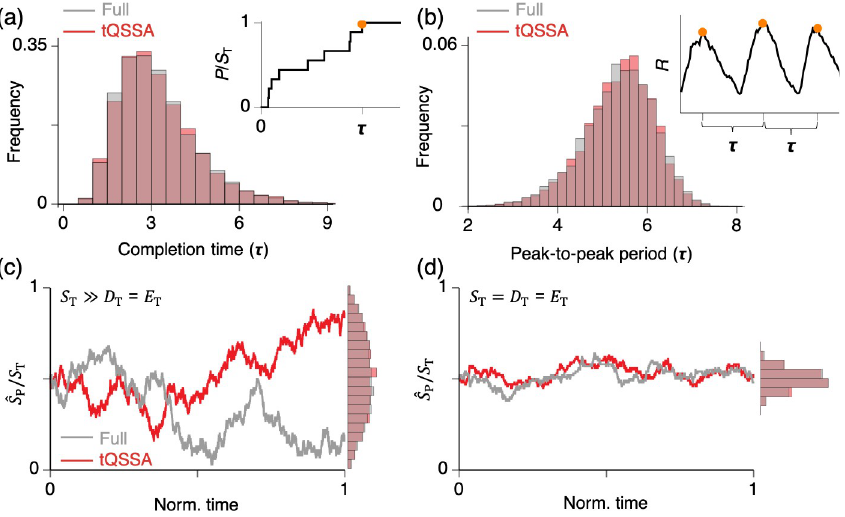
Fig 4. tQSSA provides accurate stochastic simulations. (a) Catalysis-completion time τ (see inset) of the single- substrate enzyme-catalyzed reaction (Fig 1a) varies due to stochastic fluctuations. The distributions of τ simulated with the full model (3.24 ± 1.4) and the tQSSA model (3.22 ± 1.37) are nearly identical. Here, the same parameter set and initial condition are used as in Fig 1e and O = 1. Gillespie’s stochastic simulation algorithm is used [107]. (b) The peak- to-peak period τ (see inset) of simulated oscillatory trajectories for the model of a negative feedback loop (Fig 3b) fluctuates due to stochasticity. The distributions of τ simulated by the full model (5.3 ± 0.8) and tQSSA model (5.3 ± 0.78) are nearly identical. Here, the same parameter set and initial condition are used as in the inset of Fig 3d and 3e and O = 5 × 10 − 4 . ( c–d) In both the presence (c) and absence (d) of zero-order ultrasensitivity, stochastic simulations of the full and tQSSA models lead to nearly identical stationary distributions of ^ S 0.5 ± 0.22 (c) and 0.5 ± 0.05 and 0.5 ± 0.05 (d). Here, E T = D T and the values of the other parameters are the same as used in Fig 2b and 2d for (c) and (d), respectively. Initial conditions are S p (0) = S (0) = S T /2, D (0) = E (0) = D T , and O = 1. tQSSA, total quasi-steady state